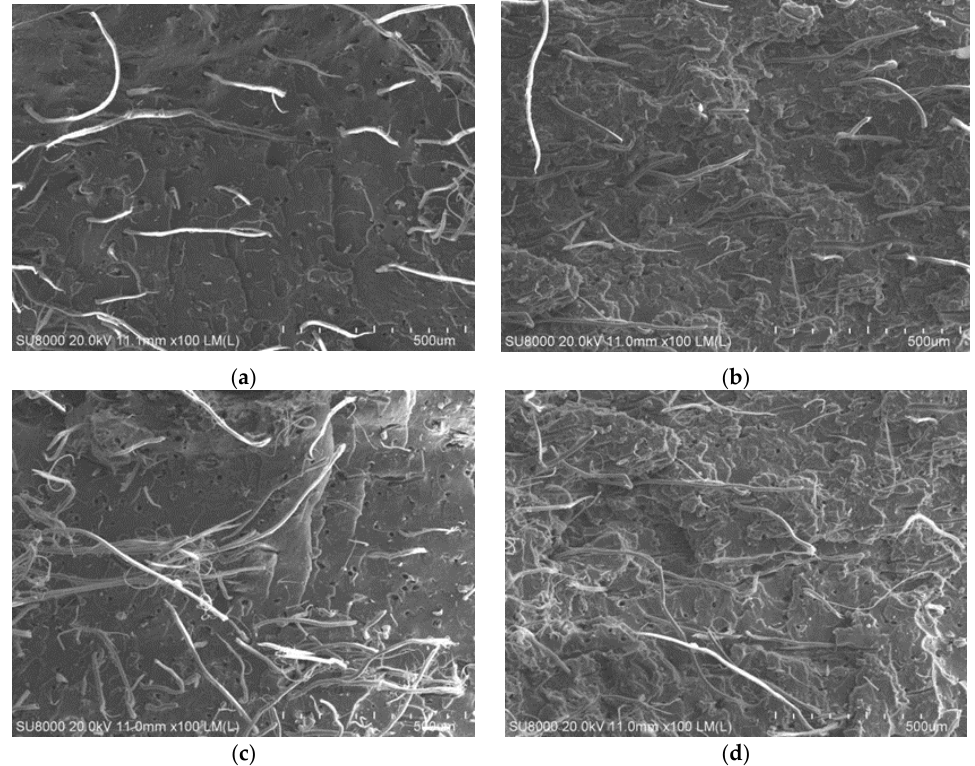
Figure 10. Sectional view of short fiber reinforced rubber composite under SEM (100): ( a ) Y-1; ( b ) Z-1; ( c ) Y-3; ( d ) Z-3.